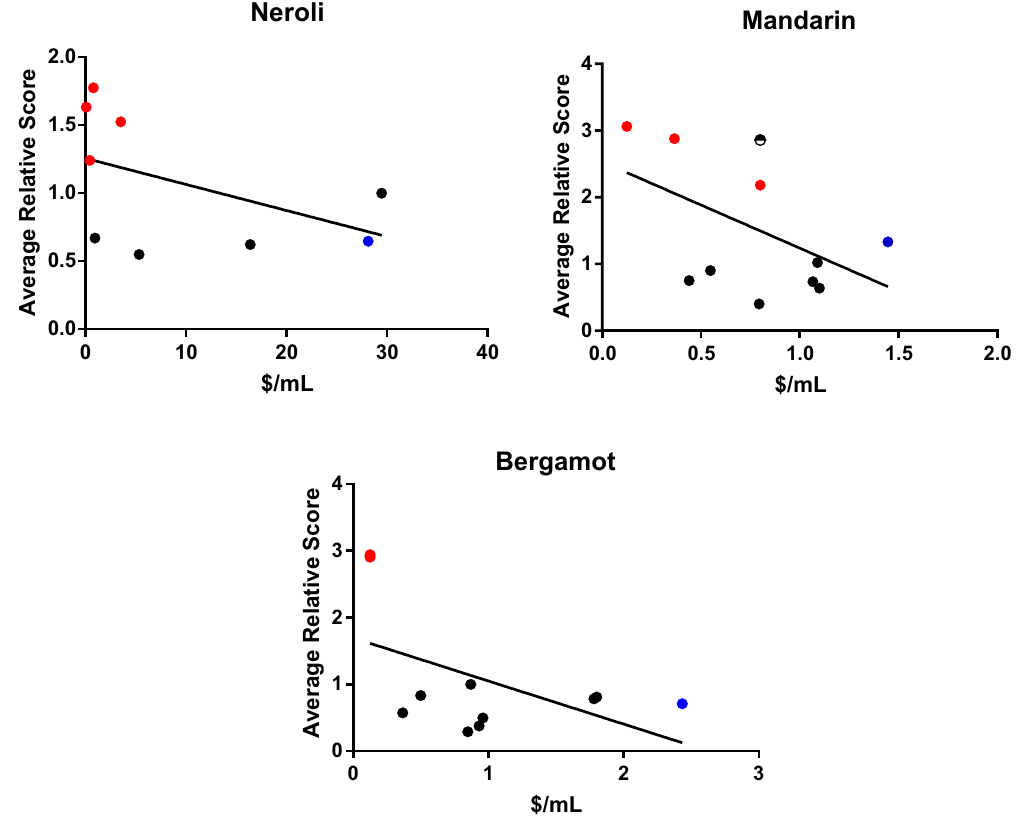
Figure 7. The average relative score of each sample is plotted against the price in USD per milliliter of essential oil (red: adulterated; black: acceptable; blue: reference; half filled circle is the tangerine